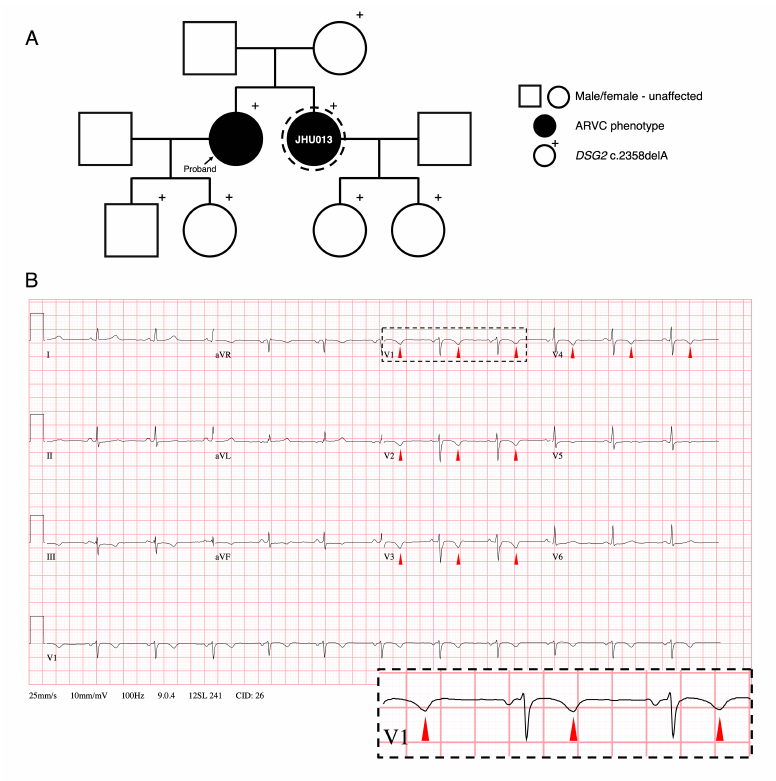
Figure 1. Family pedigree and electrocardiogram from hiPSC donor. ( A ) Family pedigree of patient JHU013 (dashed circle) harboring a pathogenic variant in desmoglein-2 ( DSG2 c.2358delA). Arrow signifies proband. ( B ) 12-lead ECG of patient JHU013 showing T wave inversion in leads V1-V4 (red markers), a classic feature in ARVC patients. Dashed box inset, highlighting T wave inversion in lead